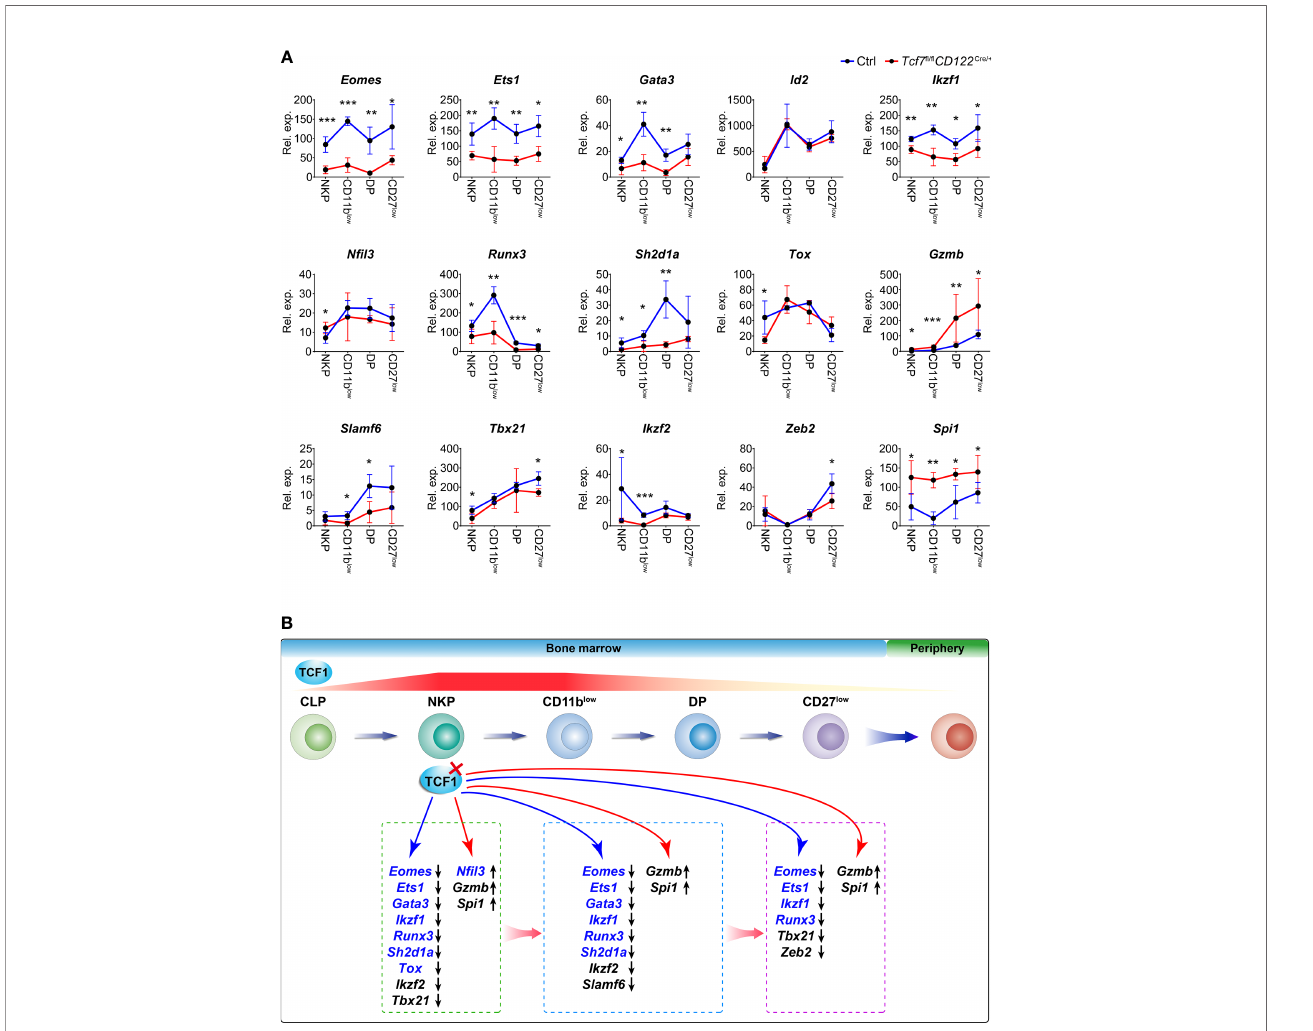
FIGURE 7 | Tcf1 de fi ciency results in aberrant expression of multiple signature genes in distinct NK subsets. (A) RNA expression of the indicated genes was measured by qPCR in NKP, CD11b low , DP, and CD27 low subsets from Ctrl and Tcf7 fl / fl CD122 Cre/+ mice. Gapdh was arbitrarily set to 1,000 and the relative expression in each subset was normalized, accordingly (n ≥ 3 for each group). All data represent at least two independent experiments. Statistical signi fi cance was determined by one-tailed Student ’ s t-test. * P < 0.05, ** P < 0.01, and *** P < 0.001. Data are means ± SD. (B) Diagram working model showing the regulation of Tcf1 in NK cell development. HSC-derived progenitor initiates the continuous processes of NK lineage differentiation from CLP to CD27 low in BM before egress into periphery. The gene expression gradient of Tcf1 (encoded by Tcf7 ) throughout NK cell development is indicated by the striped line, and the red color density variation provides an approximation of the dynamic changes in Tcf7 expression. The red cross mark represents the deletion of Tcf1 in NKP stage. The blue arrow line pointed to the downregulated genes in absence of Tcf1; the red arrow line pointed to the upregulated genes in absence of Tcf1. The Tcf1-binding genes from ChIP-seq data are highlighted in blue color. Differentially expressed genes due to Tcf1 de fi ciency are listed in the broken line circled areas which represented relative developmental phases. The black arrows following genes in the boxes indicate the downregulated expression or upregulated expression,